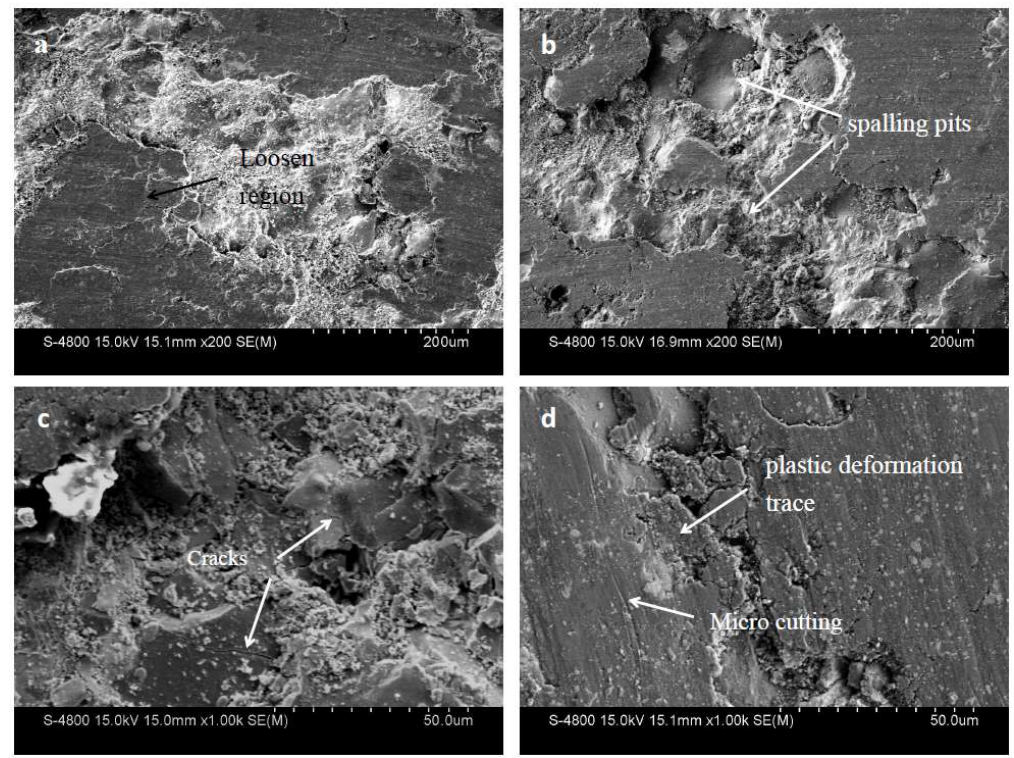
Figure 11. Wear morphology of NWC coating.